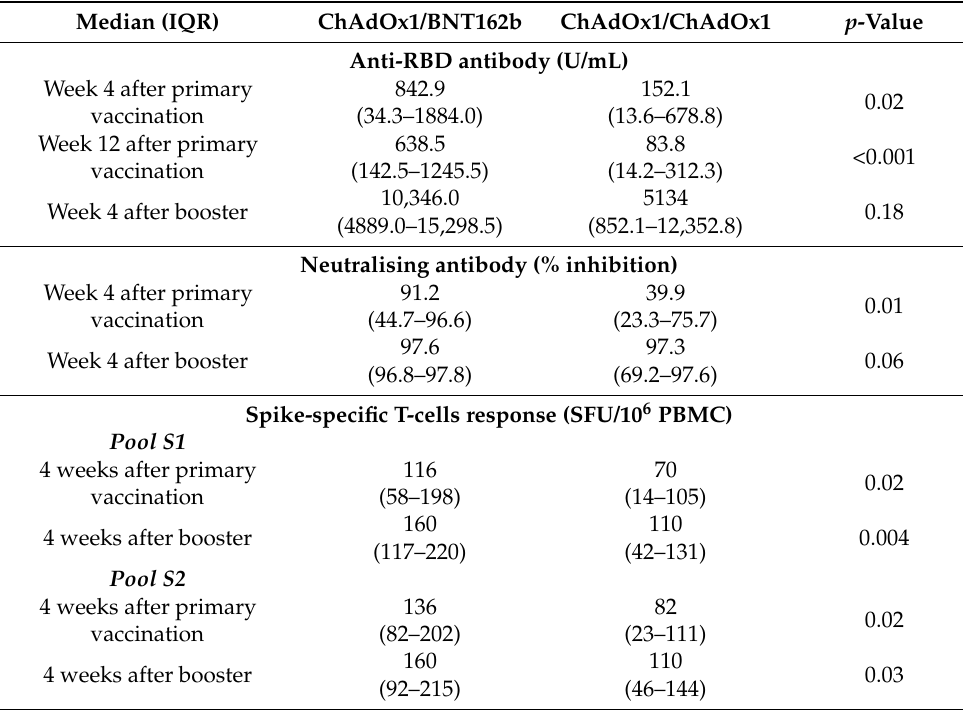
Table 2. Immune response in LT recipients after primary vaccination with heterologous or homolo- gous SARS-CoV-2